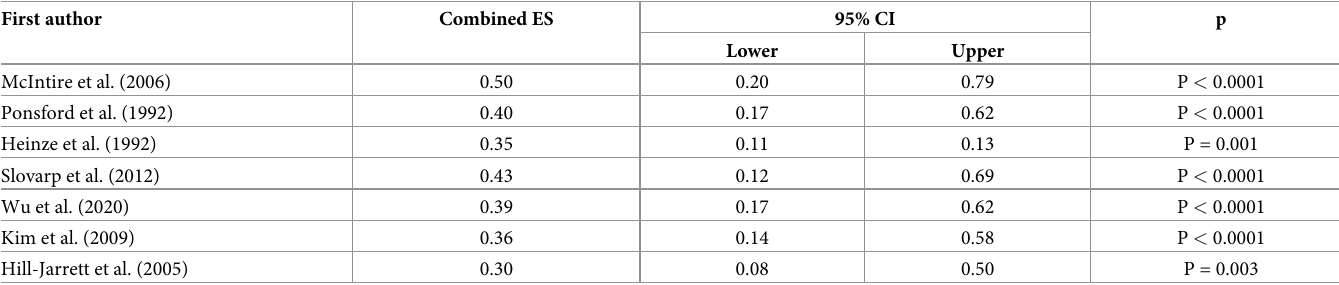
Table 5. Outcomes of a sensitivity analysis of studies in which the combined effect size for task accuracy was